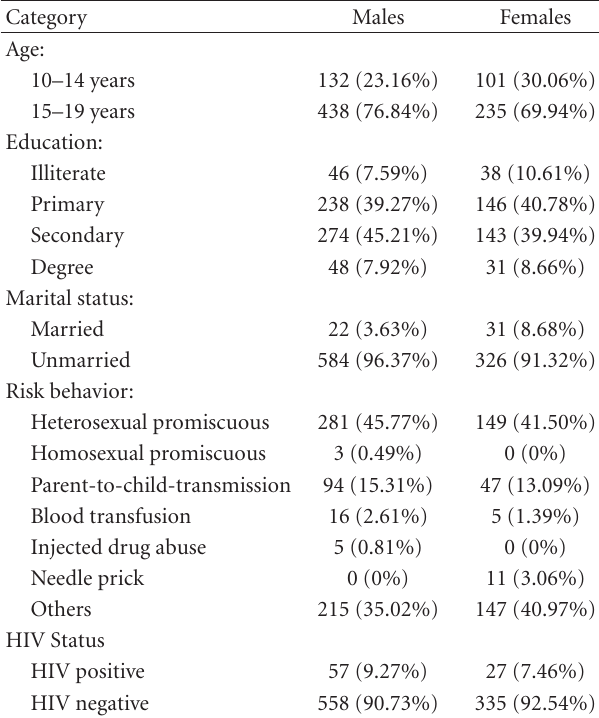
Table 1: Sociodemographic distribution of study population